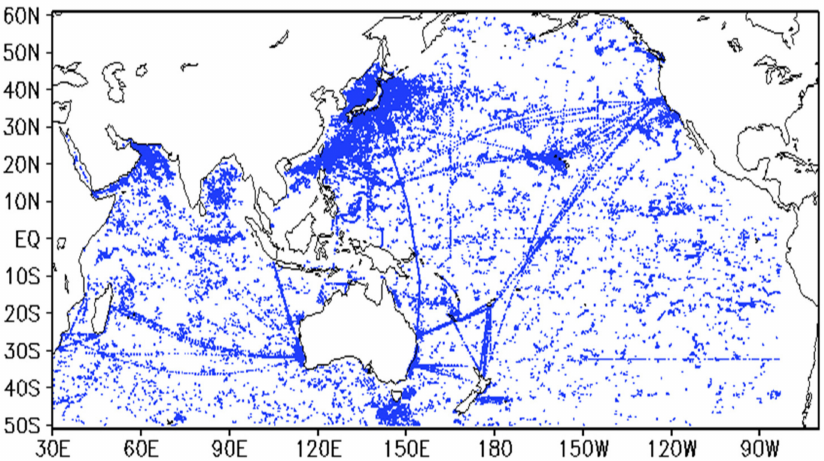
Figure 3. The distribution of temperature and salinity profiles withheld from the assimilation during the period of 2010–2011.